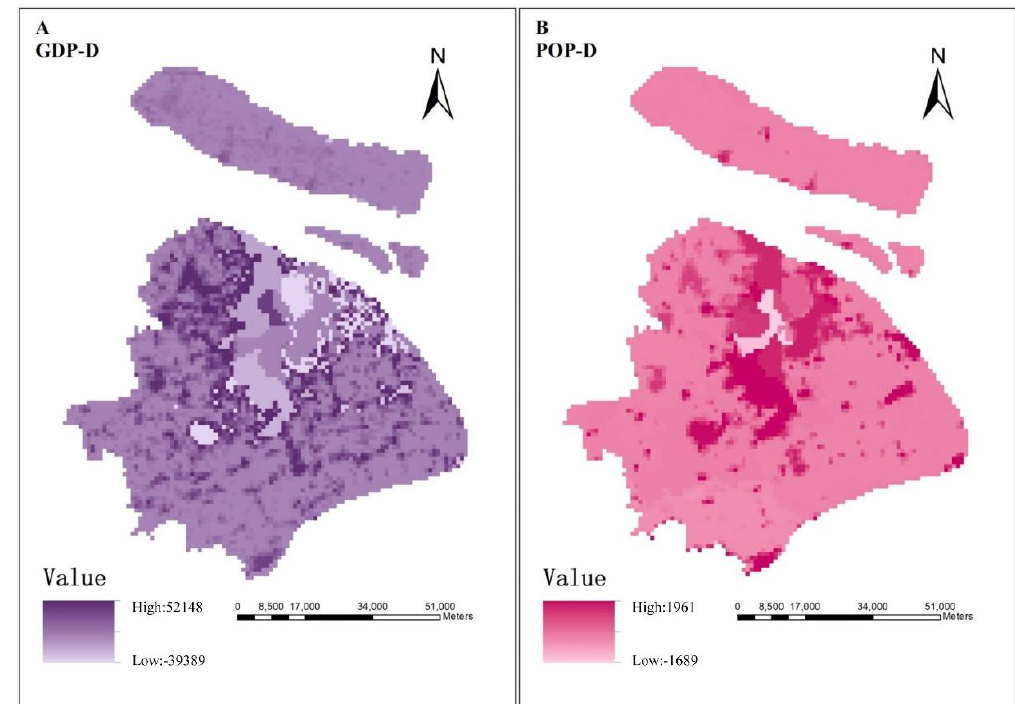
Figure 15. Spatial changes in GDP and population from 2010 to 2005 in Shanghai. ( A ): change of GDP, ( B ): change of population. Table 5. District-level urbanization indicators in Shanghai.